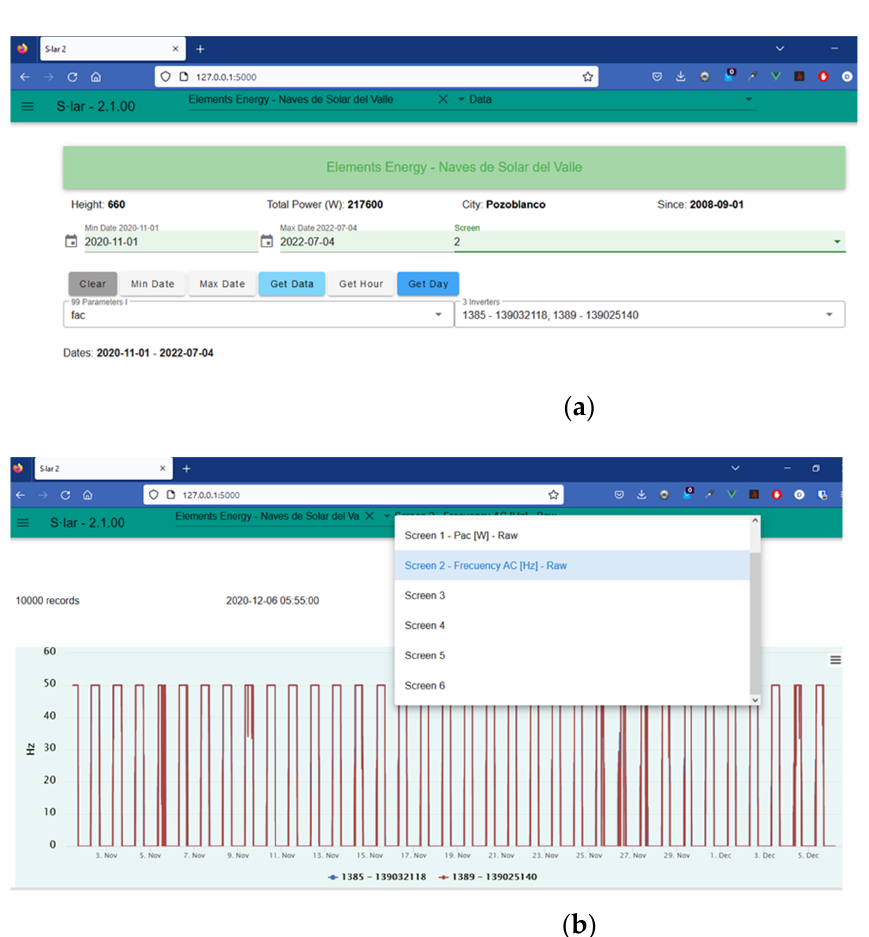
Figure 11. Image of the S·lar 2 application in which the grid frequency f ac has been selected for two inverters ( a ), and the values of this parameter are shown graphically but now on screen 2 ( b ).